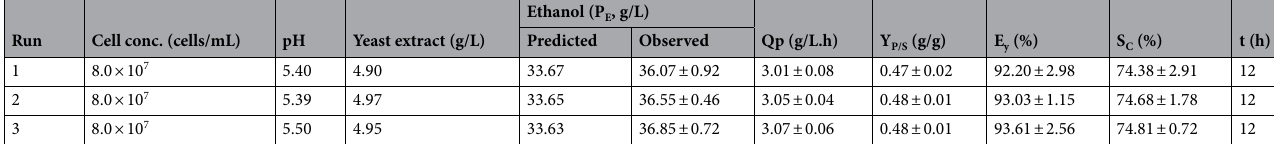
Table 9. The experimental design and results of verification experiments. P E : ethanol concentration (g/L); Q p : ethanol productivity (g/L.h); Y